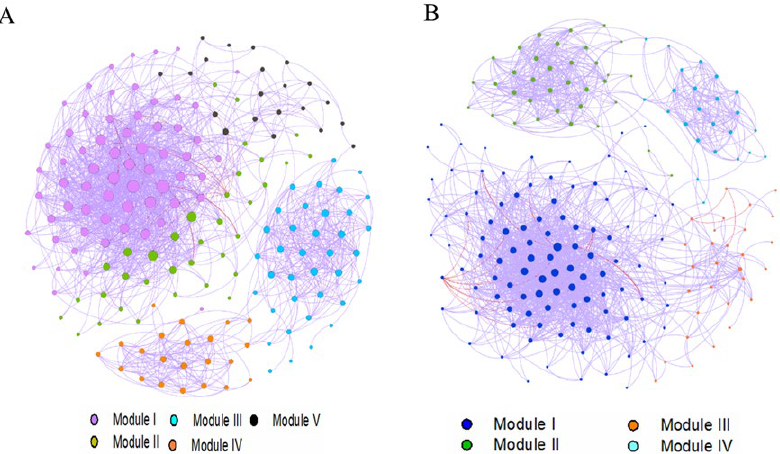
Figure 7. Network analysis of ( A ) AOA and ( B ) AOB OTUs modules. Modules were labelled with different colors in each network. The size of the OTU nodes indicates their degrees, and the purple line indicates a positive correlation, while the red line illustrates a negative correlation.